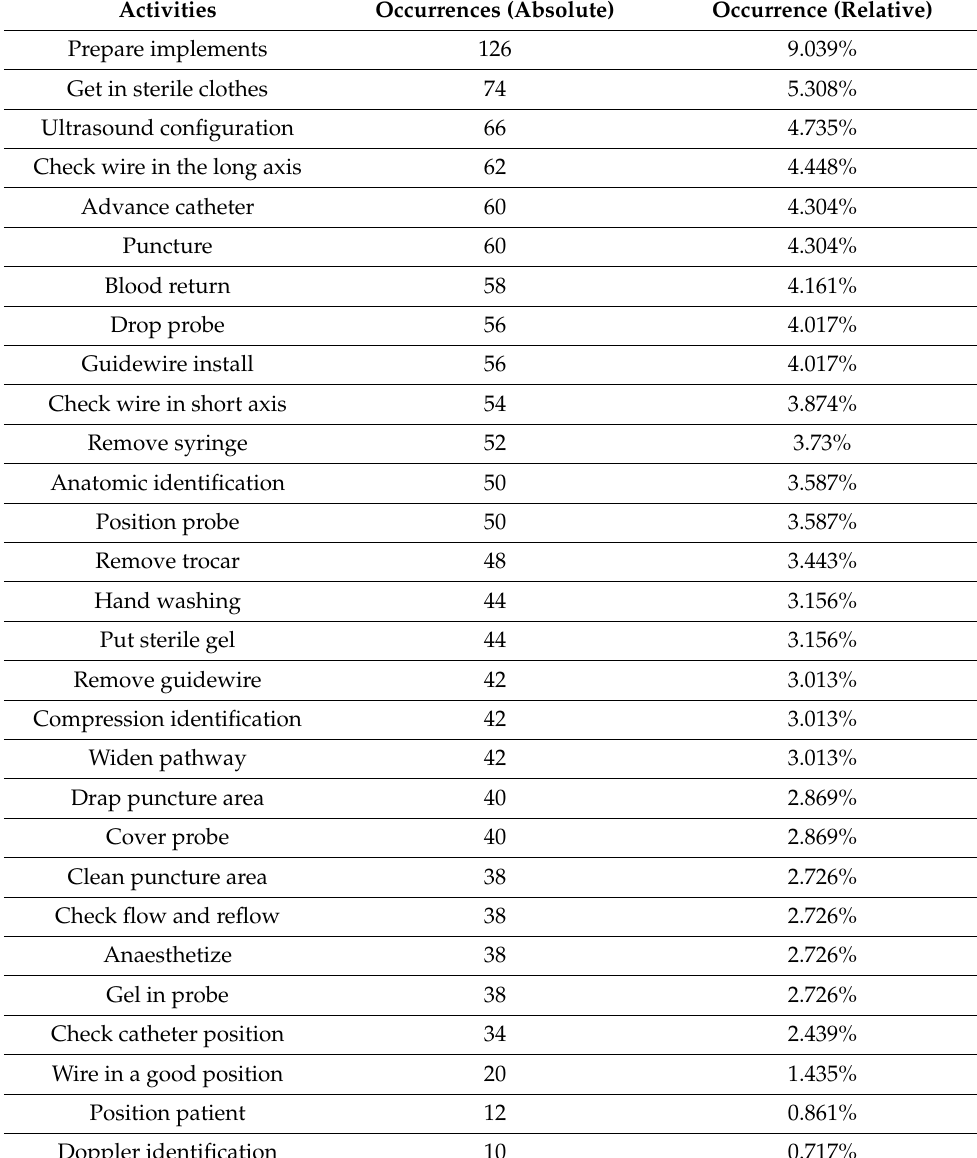
Table 1. Activities and their percentages of occurrences in the